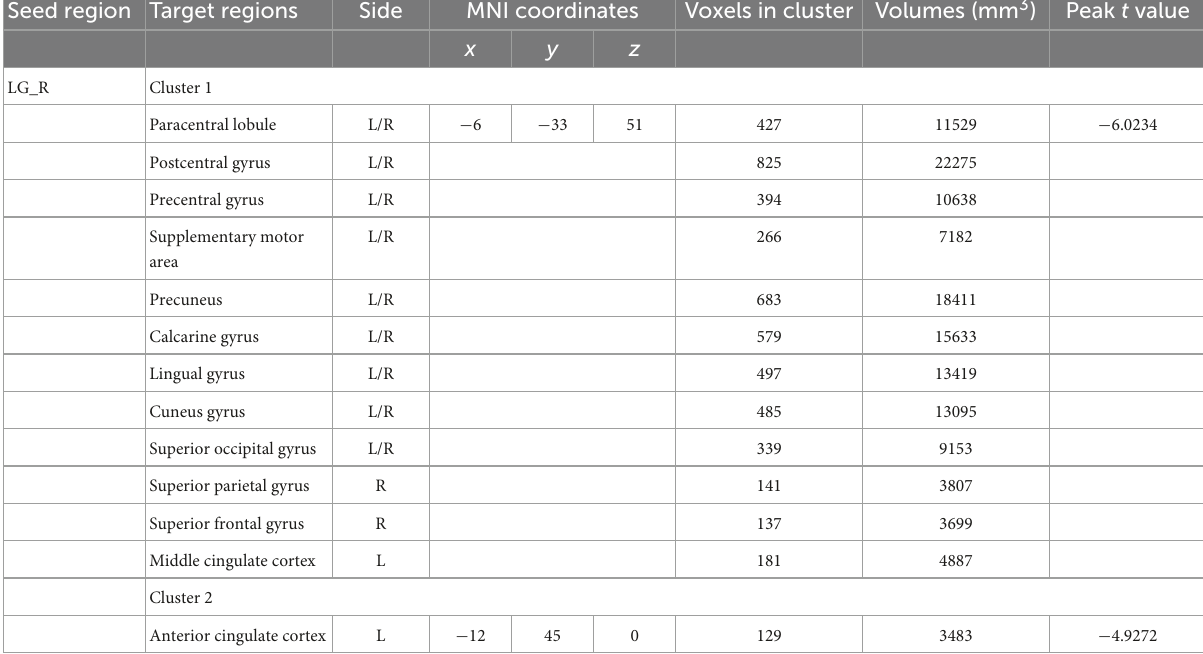
TABLE 3 Brain regions with significant differences in FC of right lingual gyrus between the CTN patients and HCs. Seed region Target regions Side MNI coordinates Voxels in cluster Volumes (mm 3 ) Peak t